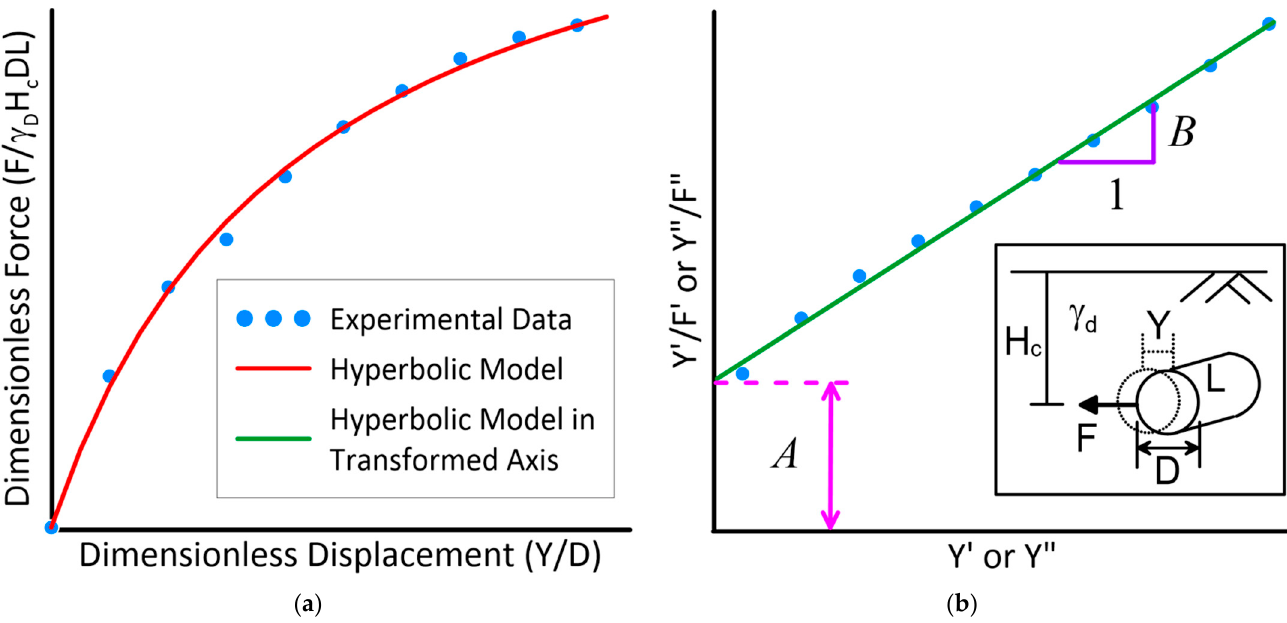
Figure 1. Diagram of transformation of ( a ) Nonlinear dimensionless force vs. displacement to a ( b ) Linear representation emphasizing A and B parameters.